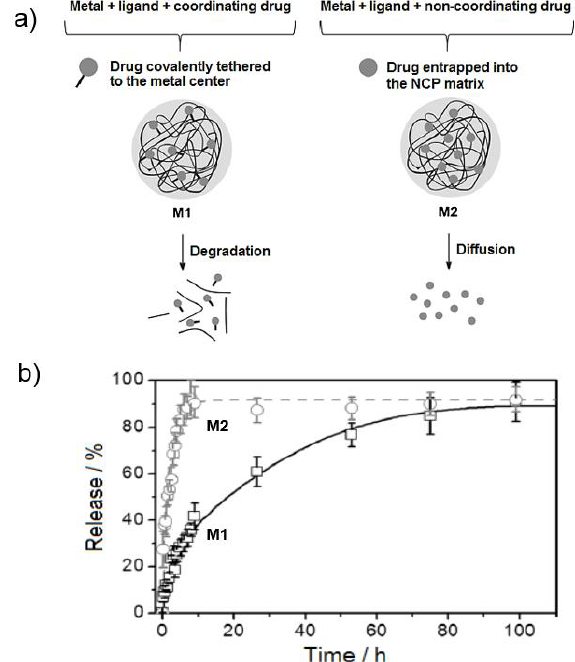
Figure 2. ( a ) Schematic of the nanostructured coordination polymers (NCPs) preparation containing a drug as a building block (M1) or entrapped into the polymeric matrix (M2). ( b ) Drug release profiles in aqueous media of guest molecules controlled by NCPs’ degradation (M1) or fast diffusion through the polymeric matrix (M2). The figure is reproduced from Reference [20] with the permission from John Wiley and Sons.